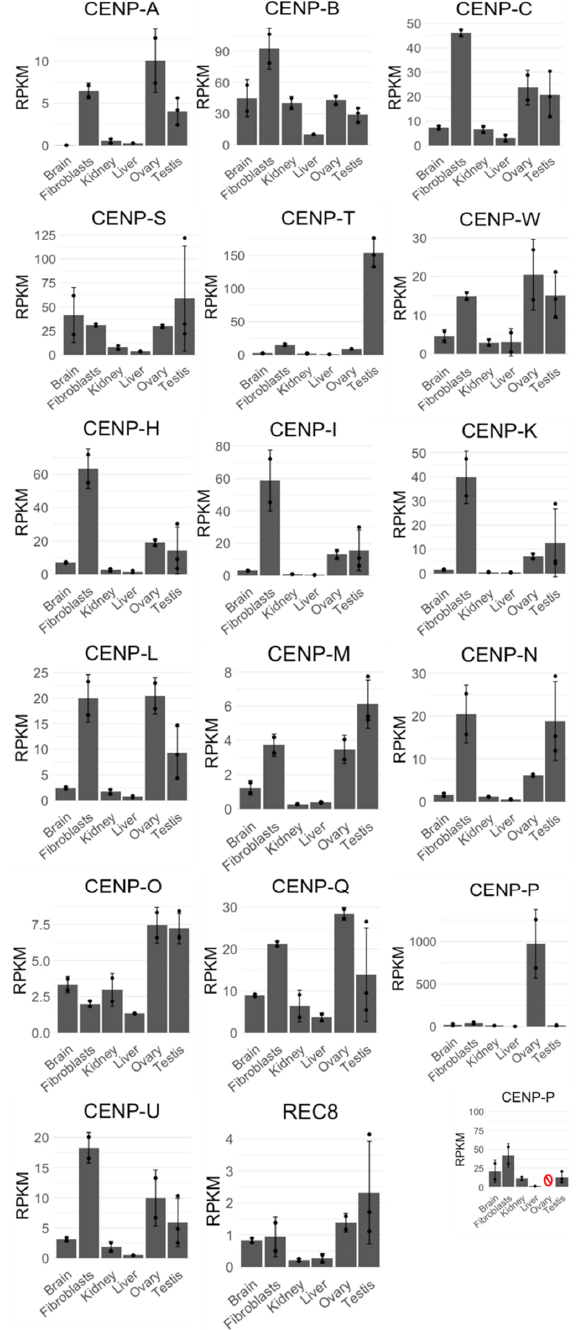
Figure A1. Expression profiles of selected platypus genes involved in chromosome segregation. Expression profiles of nucleosome and inner kinetochore components (CENP-A, B, C), central kinetochore components (CENP-S/T/W), CCAN components (CENP-H, I, K, L, M, N, O, P, Q, U), and cohesin REC8 obtained from single-end transcriptome datasets originating from RNA sequencing of different platypus tissues. Error bars represent standard deviation of mean RPKM calculated from two datasets per each tissue, except testes, where three sets were obtained. The CENP-P expression profile also has a smaller inset representing the data after removing (red symbol) the tissue with the highest RPKM value (ovary), which otherwise masks smaller RPKM values of other tissues in the original